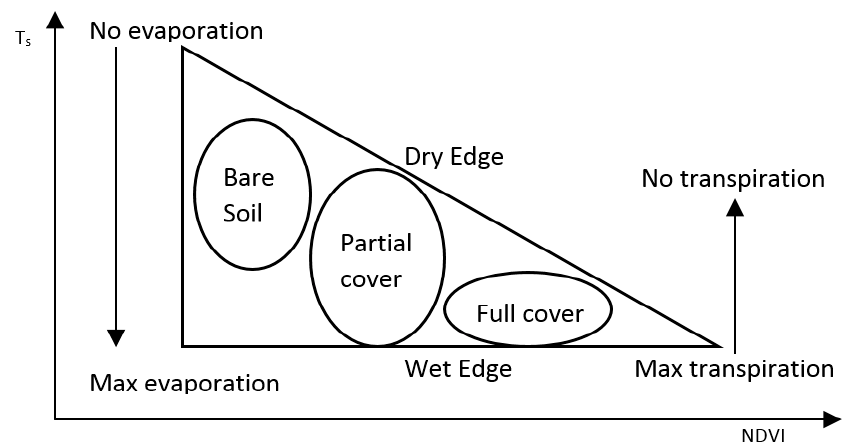
Figure 1. A conceptual Land Surface Temperature (LST) with NDVI triangle [46] X-axis shows the increasing normalized difference vegetation index from 0 to 1. Y-axis shows the increase in land surface temperature (Celsius).